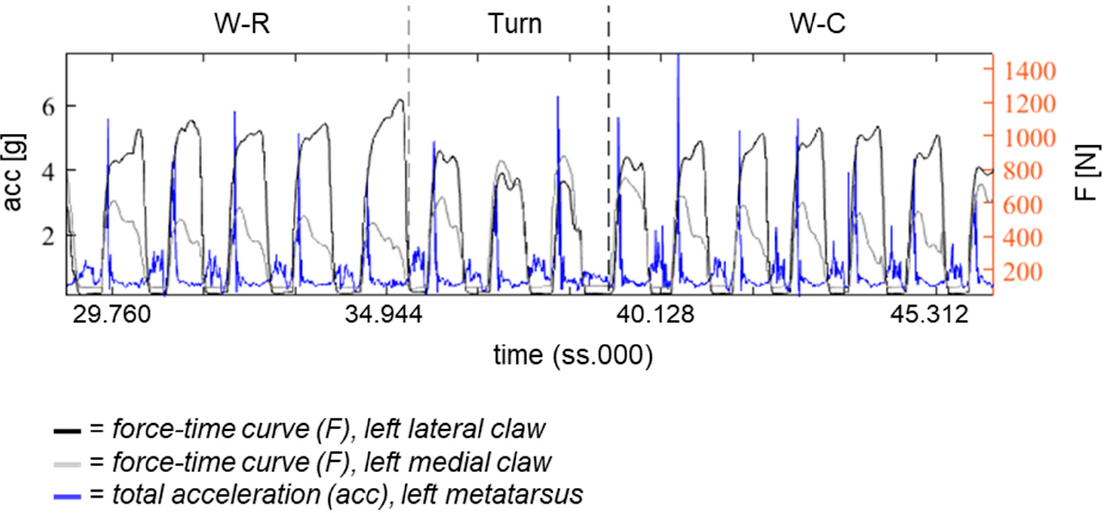
Figure 7. Combined visualization of force (F) and IMU data (acc). Exemplary gait pattern of the left hind limb of one cow is shown. Labels (W-R = walk on rubber mats, turn, W-C = walk on concrete) were transferred from the markings during measurement.